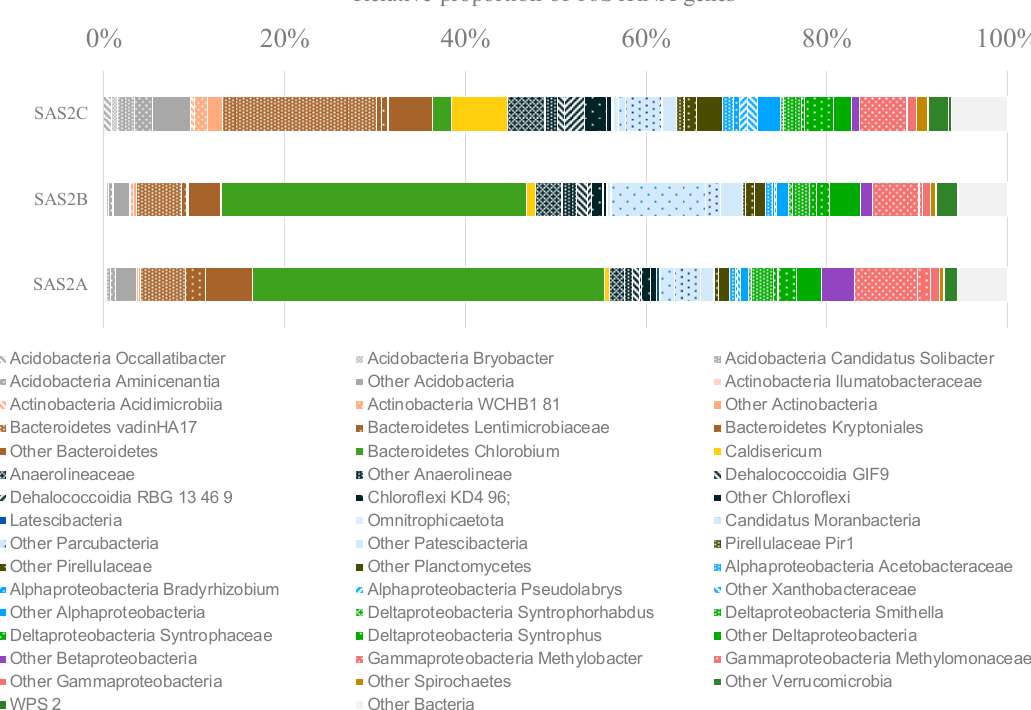
Figure 1. Bacterial community composition determined by Illumina MiSeq 16S rRNA gene sequencing. Only operational taxonomy units (OTUs) with a relative proportion of >1% are shown.